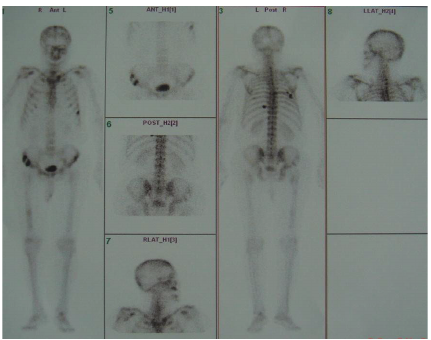
Figure 3: Bone scintigraphy, intense activity in multiple bones.